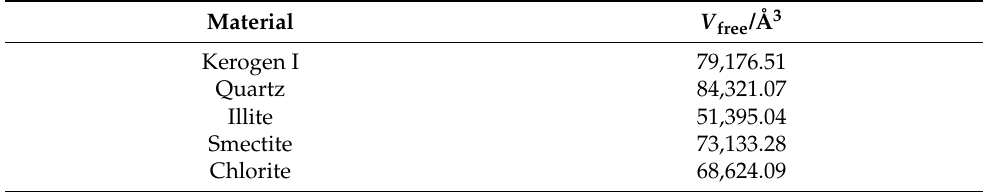
Table 2. Free Volume of pore model for several